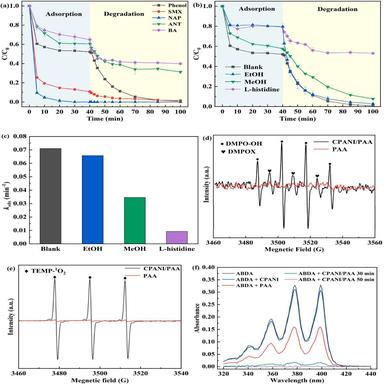
(a) Removal of different organics in the adsorption and degradation processes in CPANI/PAA system. Experimental conditions: = 25 mg L− 1 , = 10 μM, = 0.5 mM; (b) Influence of quenching reagents on adsorption and degradation of phenol and (c) kobs of phenol degradation process. Experimental conditions: = 25 mg L− 1 , = 10 μM, = 0.5 mM, = 0.5 M, = 30 mM, = 5 mM; EPR spectra attained using (d) DMPO and (e) TEMP as spin-trapping agents; (f) absorbance of ABDA under different conditions. Experimental co